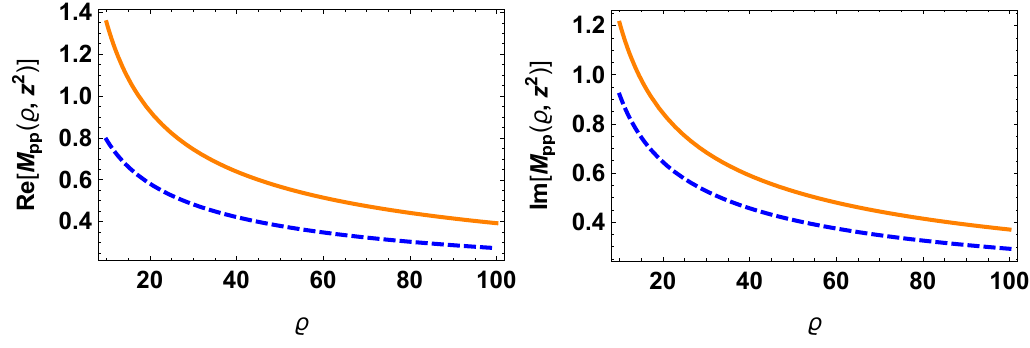
Figure 4 . In the left and in the right panel we plot the numerical evaluation of real and imaginary part of (5.11) (orange curve), and the real and imaginary part of the saddle point result (5.12) (blue dashed curve),